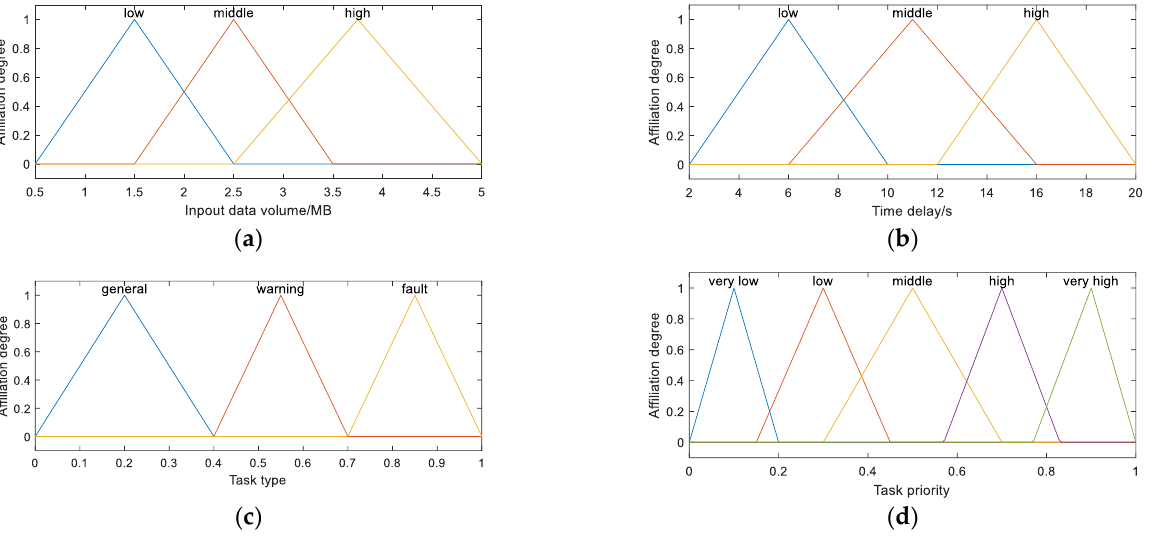
Figure 2. Diagram of affiliation degree. ( a ) Input data volume affiliation function. ( b ) Time delay affiliation function. ( c ) Task type value affiliation function. ( d ) Task priority affiliation function.